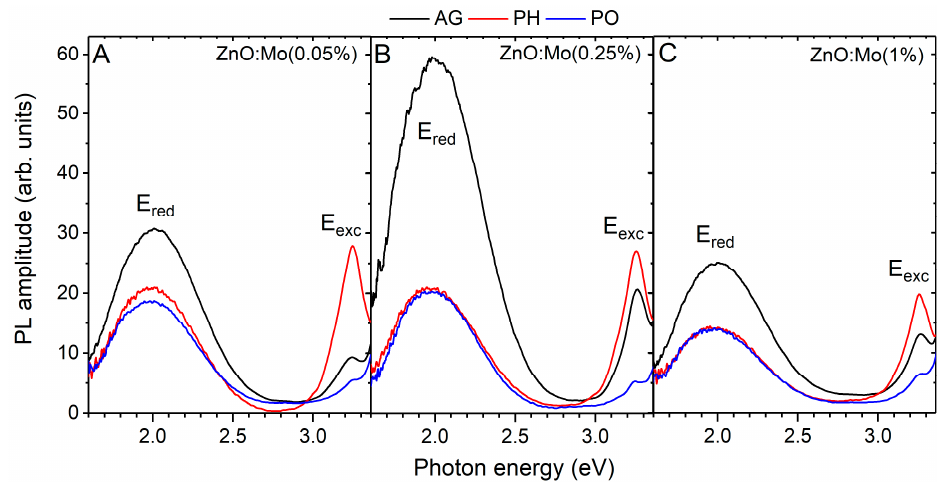
Figure 5. PL spectra measured at room temperature in: ( A )—ZnO:Mo(0.05%), ( B )—ZnO:Mo(0.25%), ( C )—ZnO:Mo(1%) samples, as-grown and exposed to hydrogen or oxygen plasma. Two emission bands are clearly visible: E red (2.00 eV) and E exc (3.25 eV). The E exc band was ascribed to the exciton emission [11–15]. It was strongest in the as-grown ZnO:Mo(0.25%) sample (by a factor of two compared to the as-grown ZnO:Mo(0.05 and 1%) samples) as has previously been reported in Ref. [20]. The E exc intensity ratio in the as-grown ZnO:Mo(0.05, 0.25 and 1%) is 1:2:1. Mo acts as a donor in ZnO [20,27,28]. Its